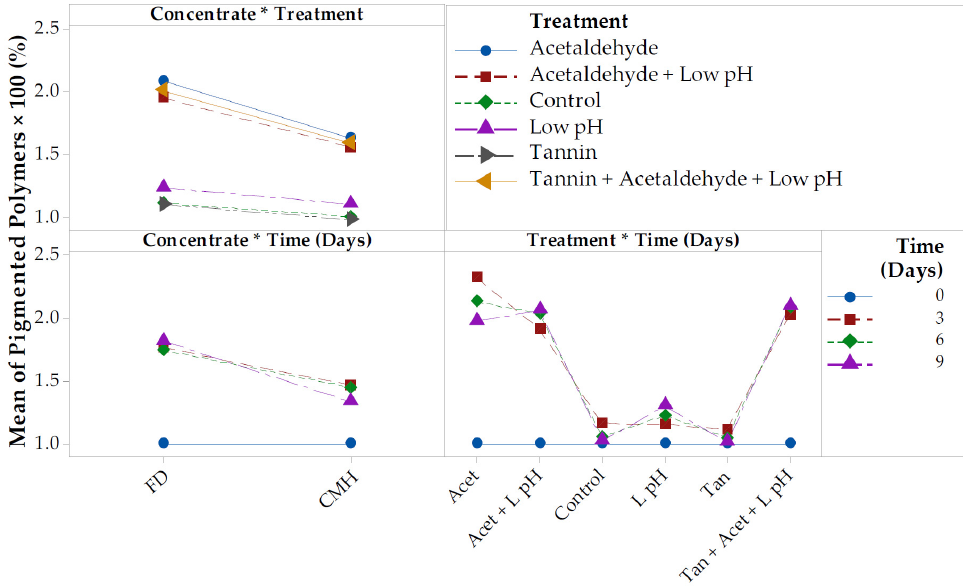
Figure 2. Fitted means for interaction plot for pigmented polymers in Rubired concentrate from conventional must heating (CMH) vs. flash détente (FD) heated at 50 °C; α = 0.05; n = 2. All data normalized to 68 °Brix and to the initial concentration to enable calculation of percentage change.